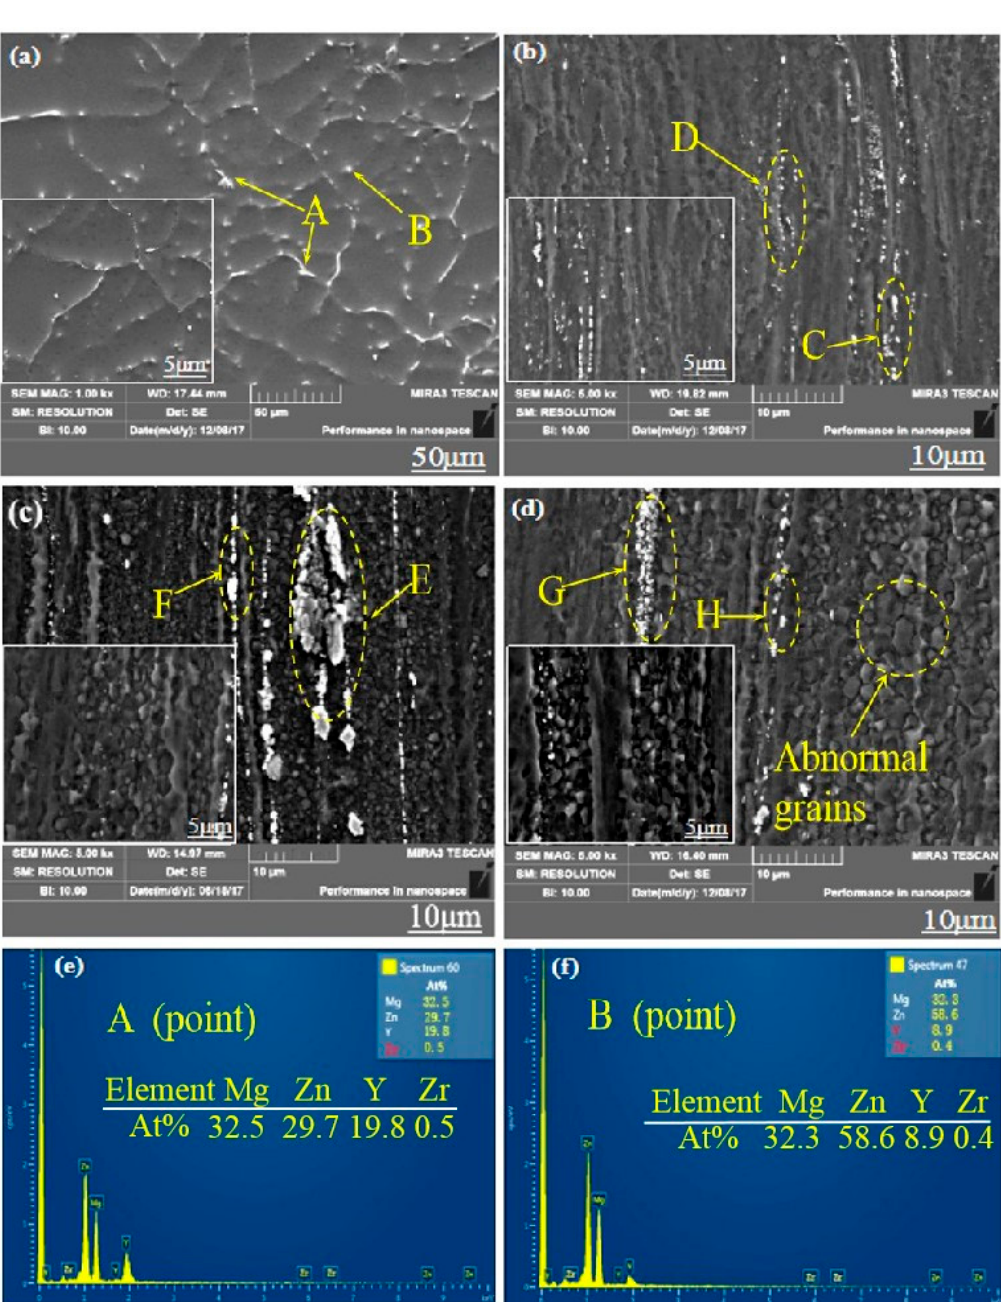
Figure 3. SEM micrographs of Mg-2Y-1Zn-0.6Zr as-cast and -extruded alloy: ( a )As-cast; ( b ) 250 ◦ C; ( c ) 300 ◦ C; ( d ) 350 ◦ C; ( e , f ) EDS spectra of extruded alloy. Table 1. The EDS analysis of second phase in the as ‐ cast and as ‐ extruded alloys.